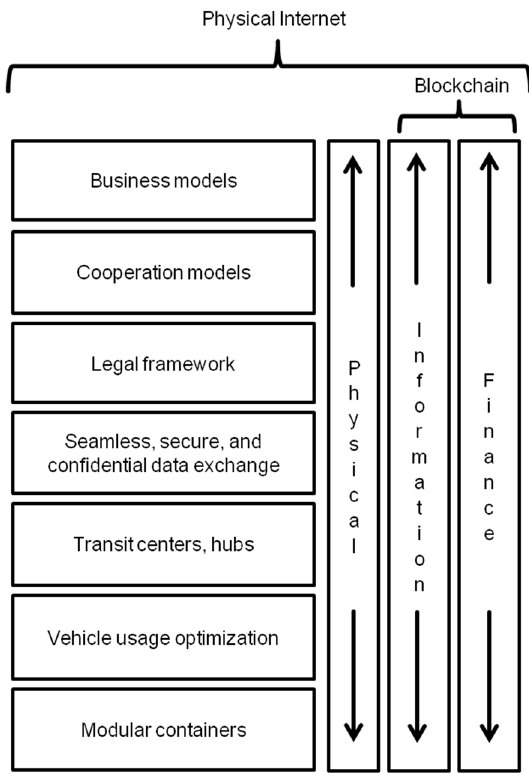
Figure 2. A layered logistics and supply chain management (SCM) research framework.